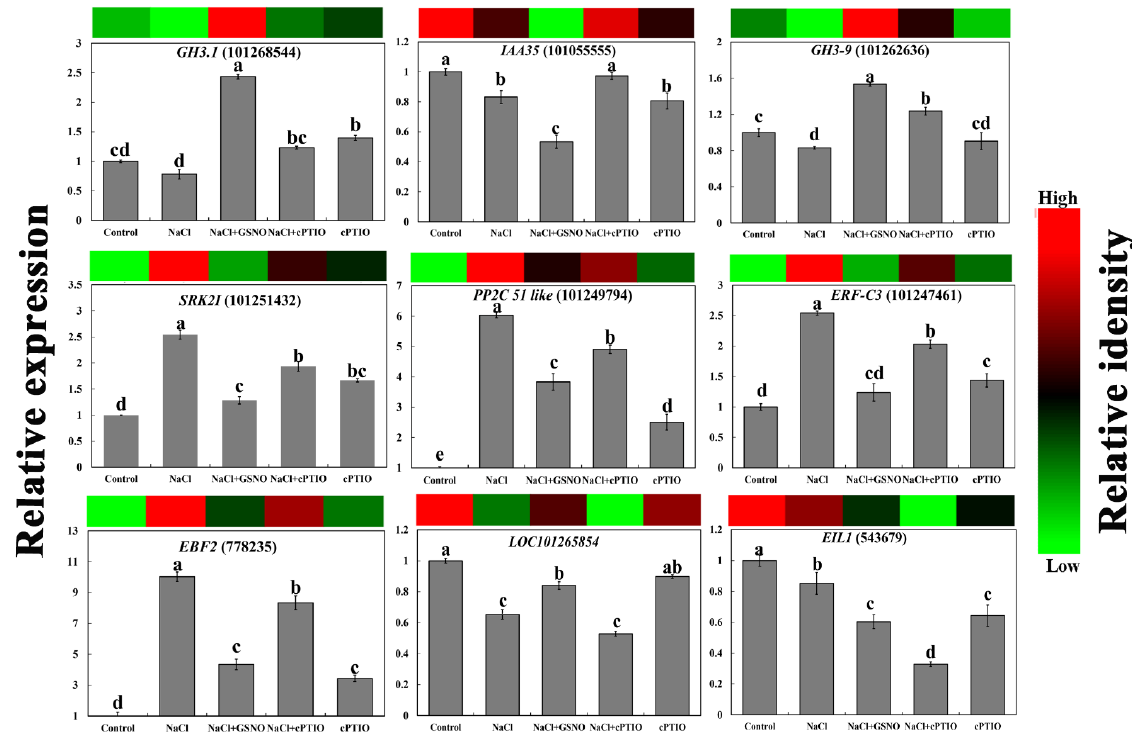
Figure 4. Quantitative real-time PCR analysis of the expression profiles of nine genes related to hormone signal transduction during NO alleviation of salt stress. The color scale corresponds to relative expression values of genes, with red indicating upregulation and green indicating downregulation. The error line is the standard error. Different letters mean significant difference by Duncan’s multiple range test (p < 0.05).